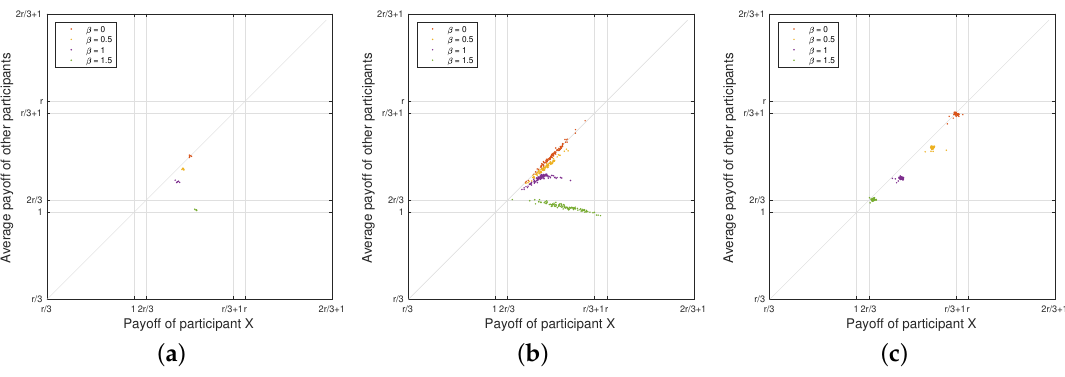
Figure 4. The payoff of the Adaptive Equalizer (AE) strategy versus other strategies. ( a ) AE Strategy versus WSLS Strategy; ( b ) AE Strategy versus Random Strategy; ( c ) all with AE